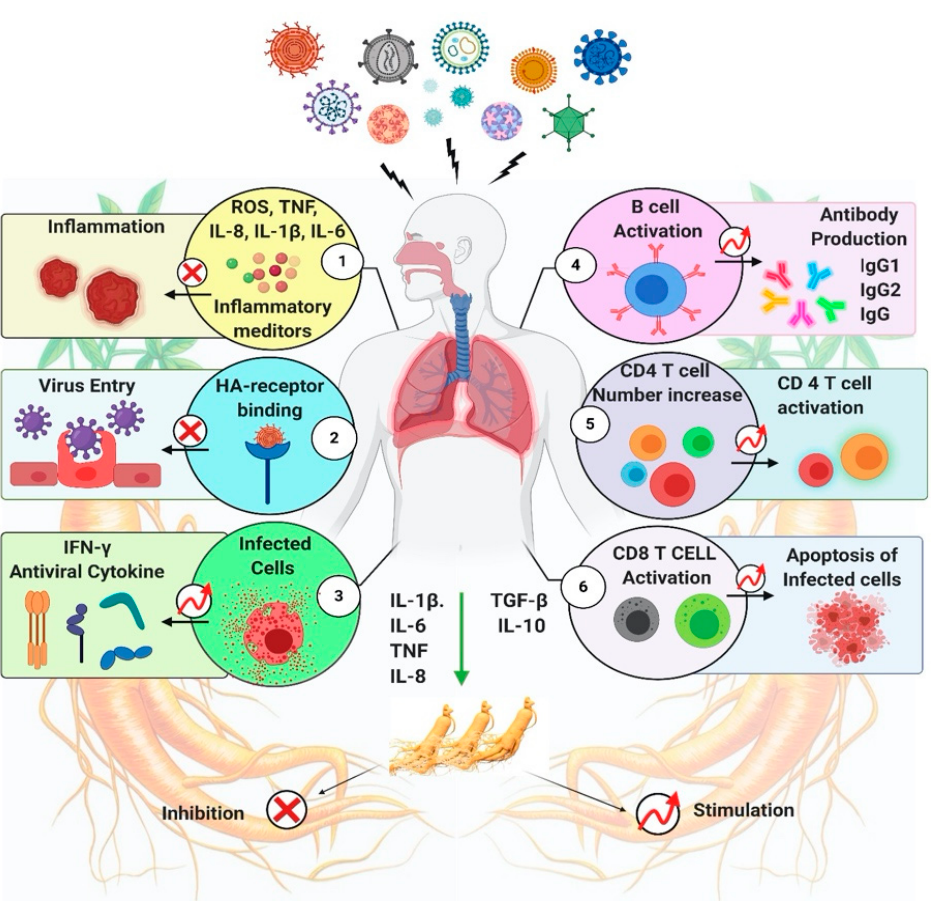
Figure 4. A summary of the impact of ginseng on respiratory virus infections. Ginseng is believed to interrupt through multiple mechanism and shows antiviral effect against respiratory viruses. ( 1 ) Ginseng shows anti-inflammatory effects by suppressing inflammatory mediators IL-6, IL-1 β , IL-8,